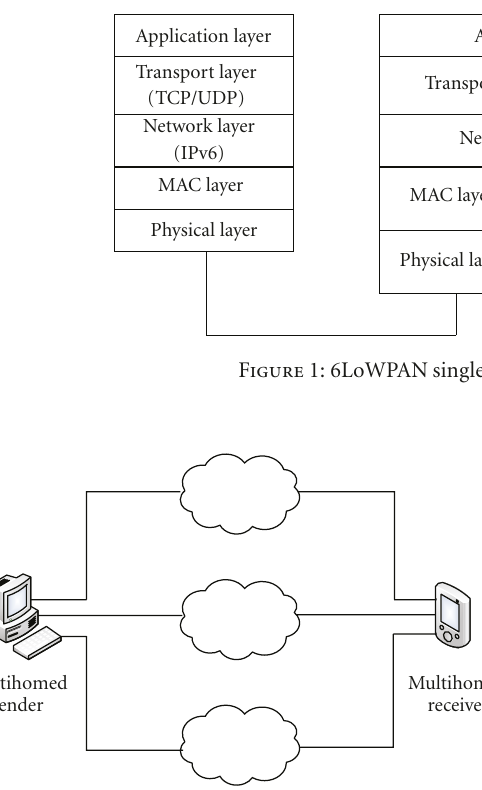
Figure 2: Parallel sessions between two multihomed end